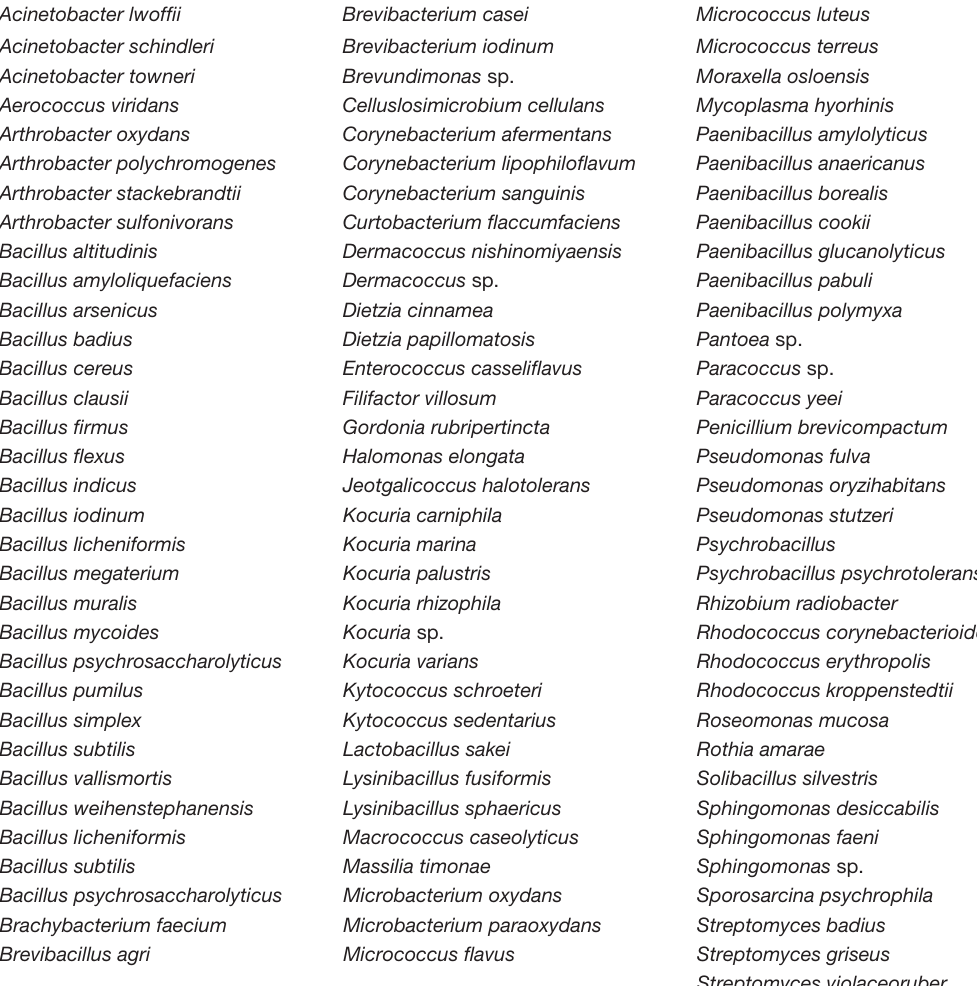
Table A1. Bacterial species found in more than one of 57